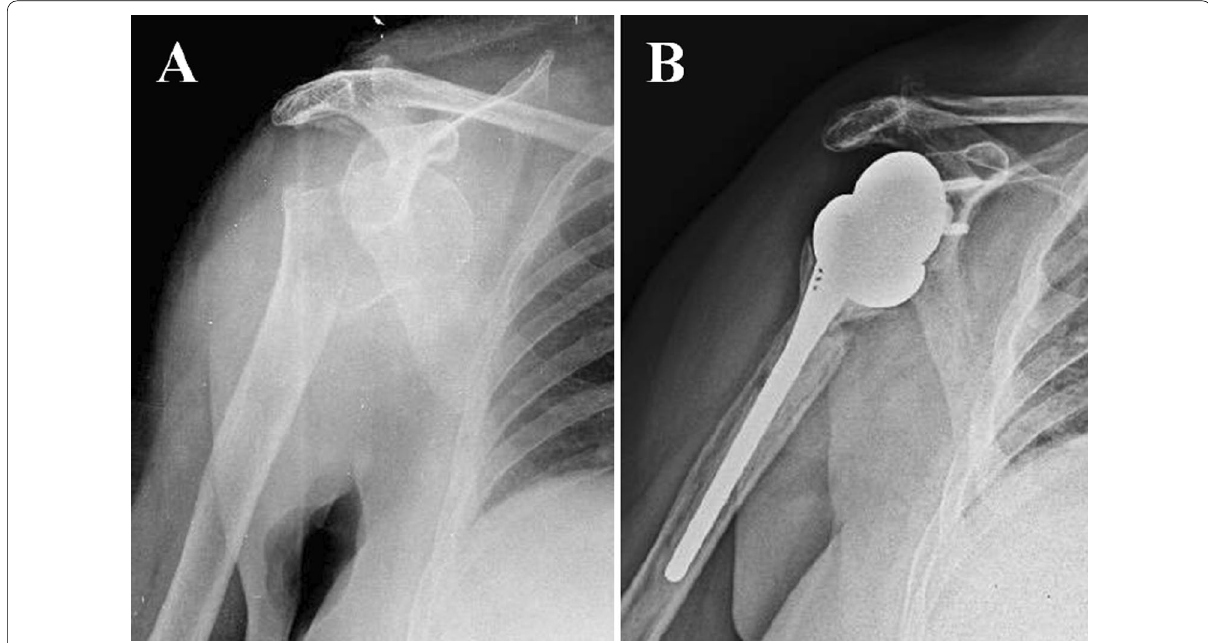
Fig. 4 These images show X‑rays of the same patient, with a complex dislocated fracture of the proximal humerus ( A ) and his follow‑up